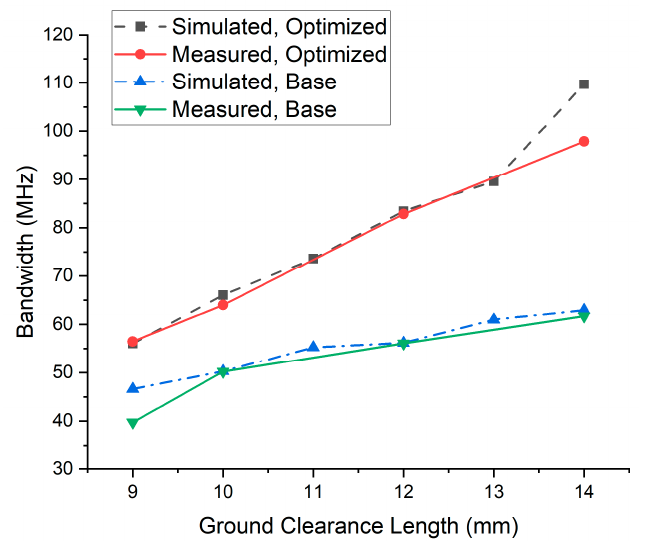
Figure 7. Comparison of the measured bandwidths with the simulated bandwidths for both the optimized and base IFA’s.